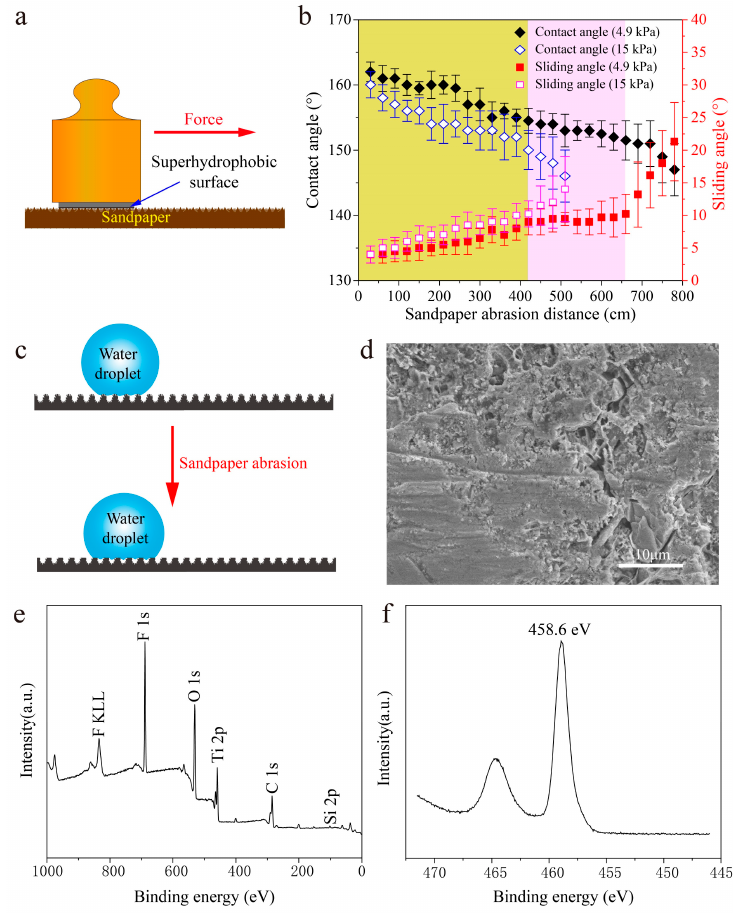
Figure 10. Mechanical stability of the as-prepared superhydrophobic surface. ( a ) Illustration of the abrasion test for the as-prepared superhydrophobic surface. ( b ) Plot of the changes of CA and SA under di ff erent mechanical abrasion distances. ( c ) The anti-wear schematic of the as-prepared superhydrophobic surface. ( d ) Surface morphology of the as-prepared superhydrophobic surface after 660 cm abrasion distance. ( e ) XPS of survey spectrum of the as-prepared superhydrophobic surface after 660 cm abrasion distance. ( f ) High-resolution XPS scanning of the Ti 2p spectrum of the as-prepared superhydrophobic surface after a 660 cm abrasion